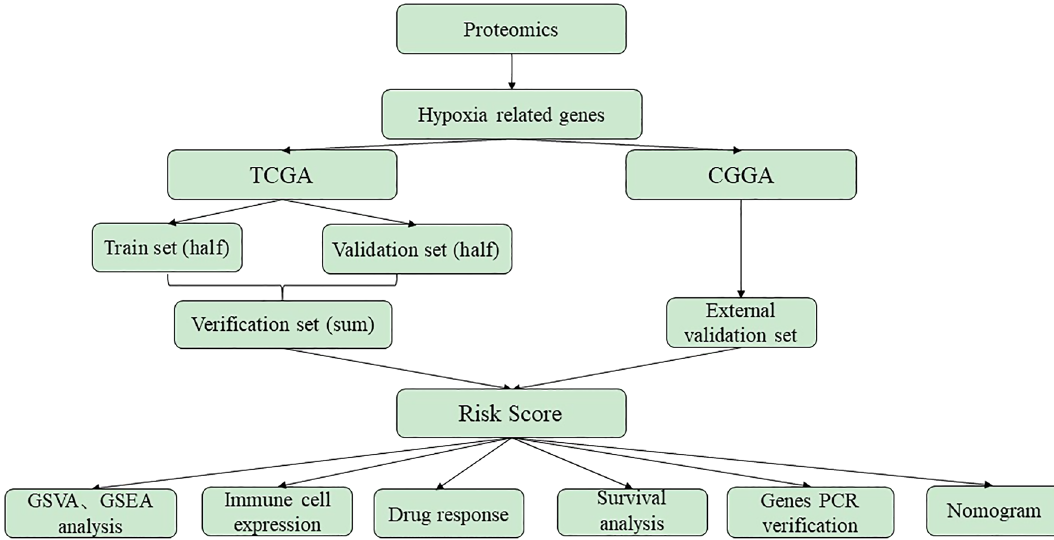
Figure 1. The workflow of generating proteomics-based hypoxia GBM risk score